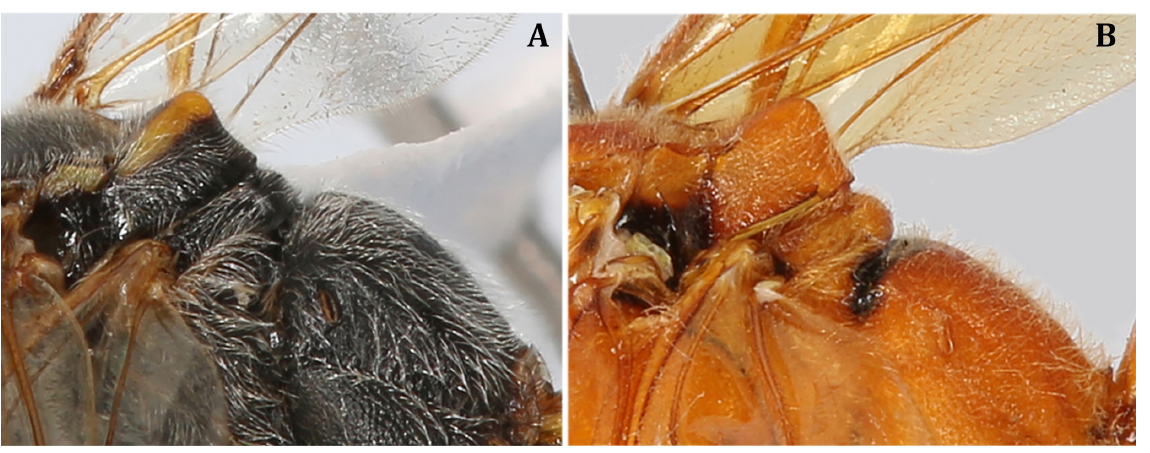
Fig. 4. Lateral view of scutellum. A . Exetastes tullu sp. nov. holotype, ♀ (MUSM). B . Exetastes andensis sp. nov. paratype, ♀